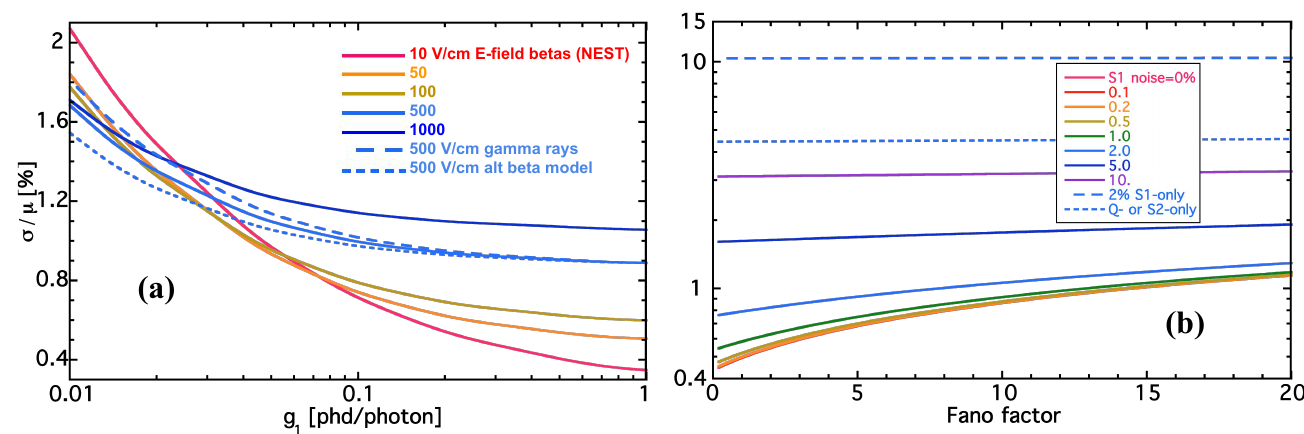
Figure 3. ( a ) The 2.5 MeV resolution in LXe according to NEST vs. g 1 and fields. For one reasonable field, 500 V/cm, system- atic uncertainty due to model choice shown: dashed cyan is the NEST electron recoil (ER) model based on photoabsorption gamma data, solid is the ER model from gamma Compton scattering and betas, and dotted line is a different beta model, based on [24]. The differences are most significant at low g 1 , where the exact L y value is more important. It is a key question for nEXO whether yields are more beta- or gamma-like. ( b ) The middle-of-the-road default beta model was selected, and g 1 and field frozen at 0.1 and 500 V/cm, and the resolution as a function of the Fano factor assumed is presented, for different levels of noise in the S1 (primary scintillation) signal. As on the left, combined E used, except for the dashed line (S1) and dotted (S2 or Q) for comparison to more detectors, as close to the max (worst)